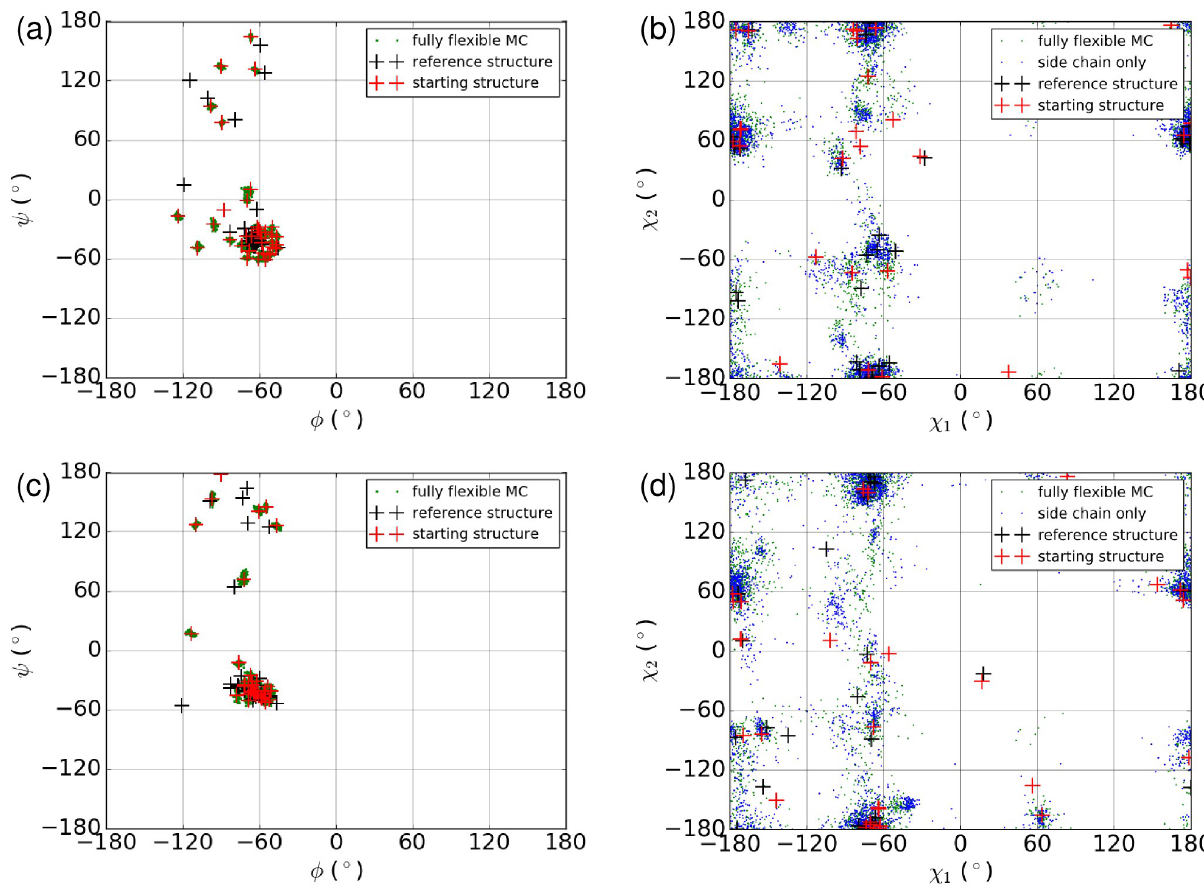
Fig 7. Examination of backbone and sidechain flexibility for two compounds. Ramachandran and Janin ( χ 1 vs. χ 2 ) plots are shown for for final conformations from docking runs for (a)-(b) genistein and (c)-(d) raloxifene. Plots include only amino acids in the atomistic region. The reference structure is the corresponding crystal structure for each cross-docked